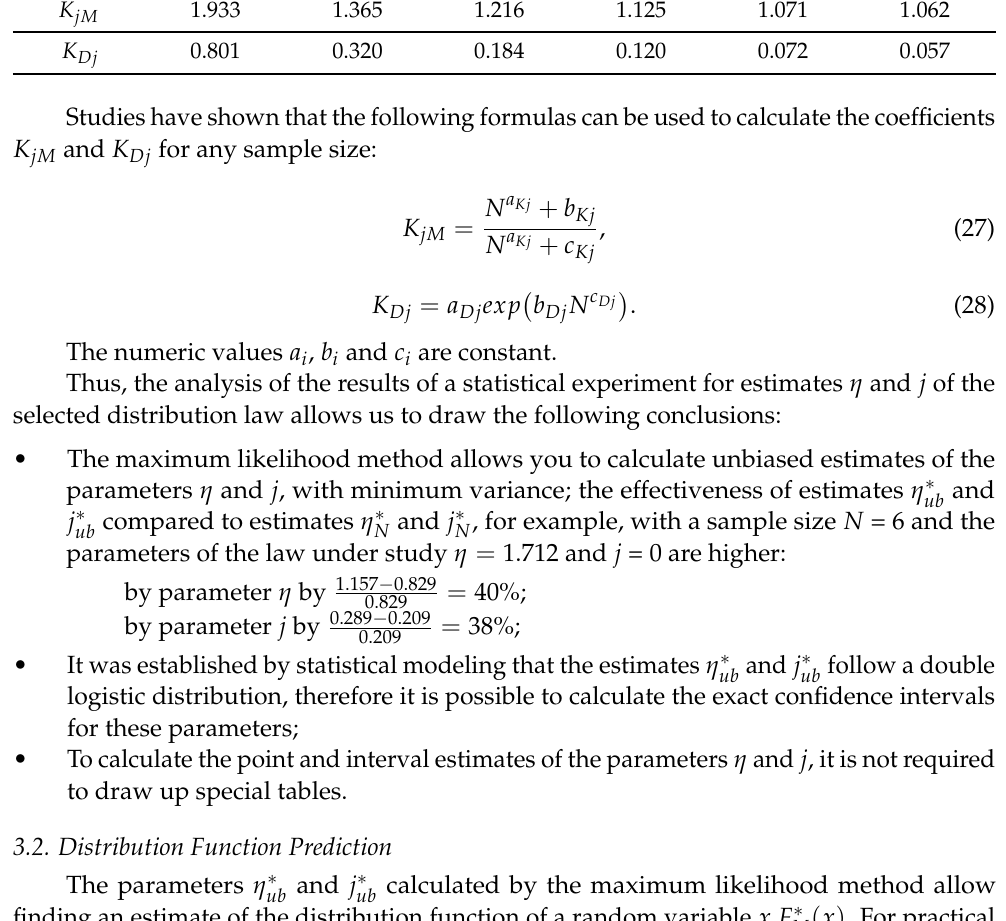
Table 6. Experimental values of the coefficients K jM and K Dj .